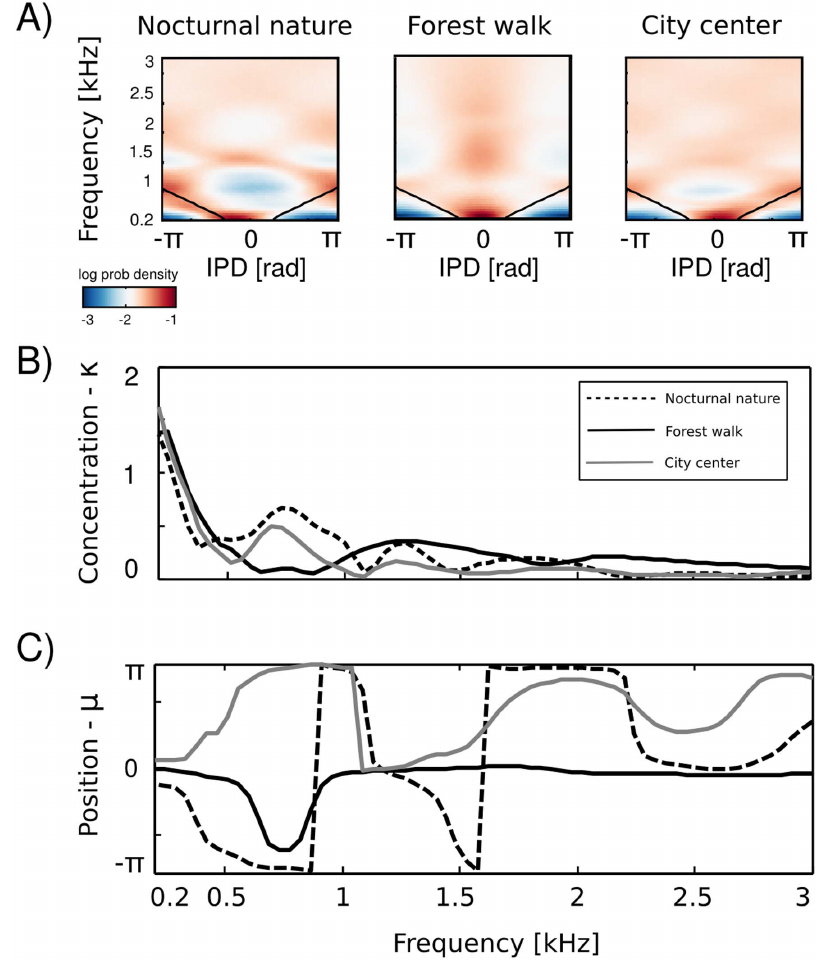
Figure 6. IPD distributions. A) Log-histograms plotted as a function of frequency. Black lines mark the ‘‘maximal’’ IPD limit. B) The concentration parameter k v of fitted von-Mises distributions plotted as a function of frequency C) The position parameter m v plotted as a function of frequency.